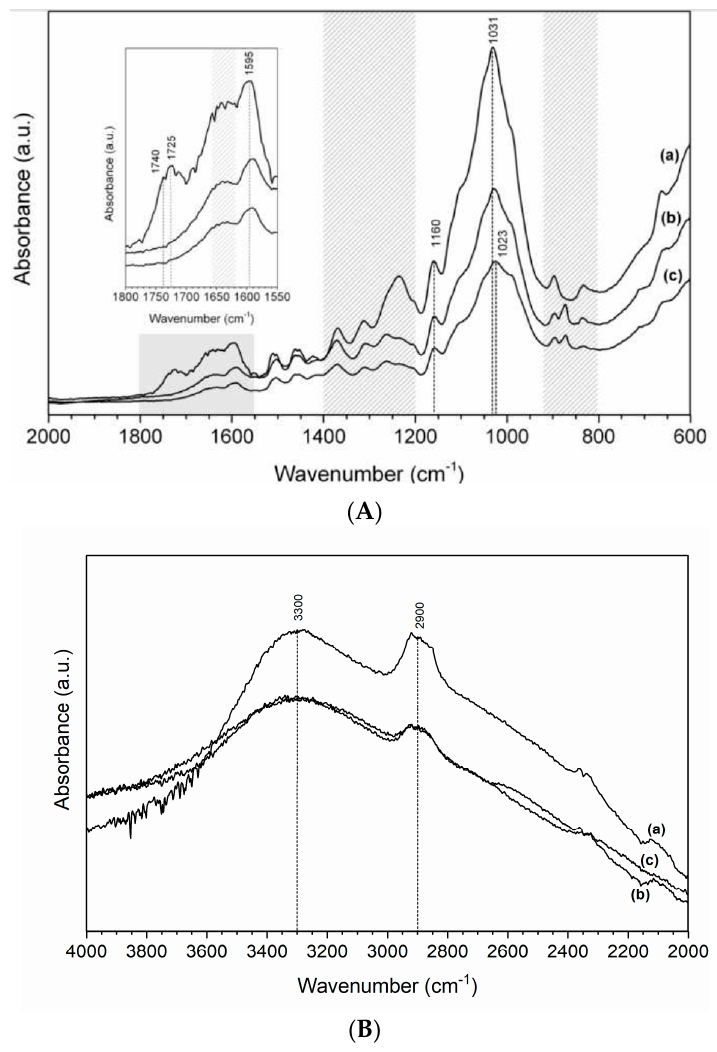
Figure 7. ( A ) FTIR spectra between 2000 and 600 cm − 1 obtained for (a) bamboo fibers in their pristine state (untreated), (b) mercerized bamboo fibers (treated unwashed) and (c) mercerized bamboo fibers after washing plus filtering (treated washed filtered). The inset shows a zoom of the absorption bands from 1800 to 1550 cm − 1 . ( B ) FTIR spectra between 4000 and 2000 cm − 1 obtained for (a) bamboo fibers in their pristine state (untreated); (b) mercerized bamboo fibers (treated unwashed) and (c) mercerized bamboo fibers after washing plus filtering (treated washed filtered).